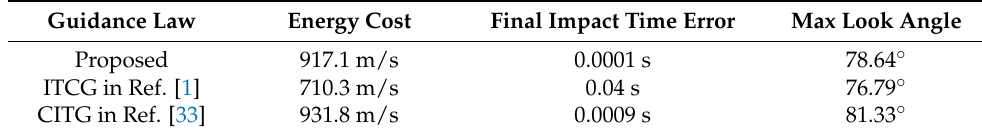
Table 7. Characteristics for T d = 50 s.